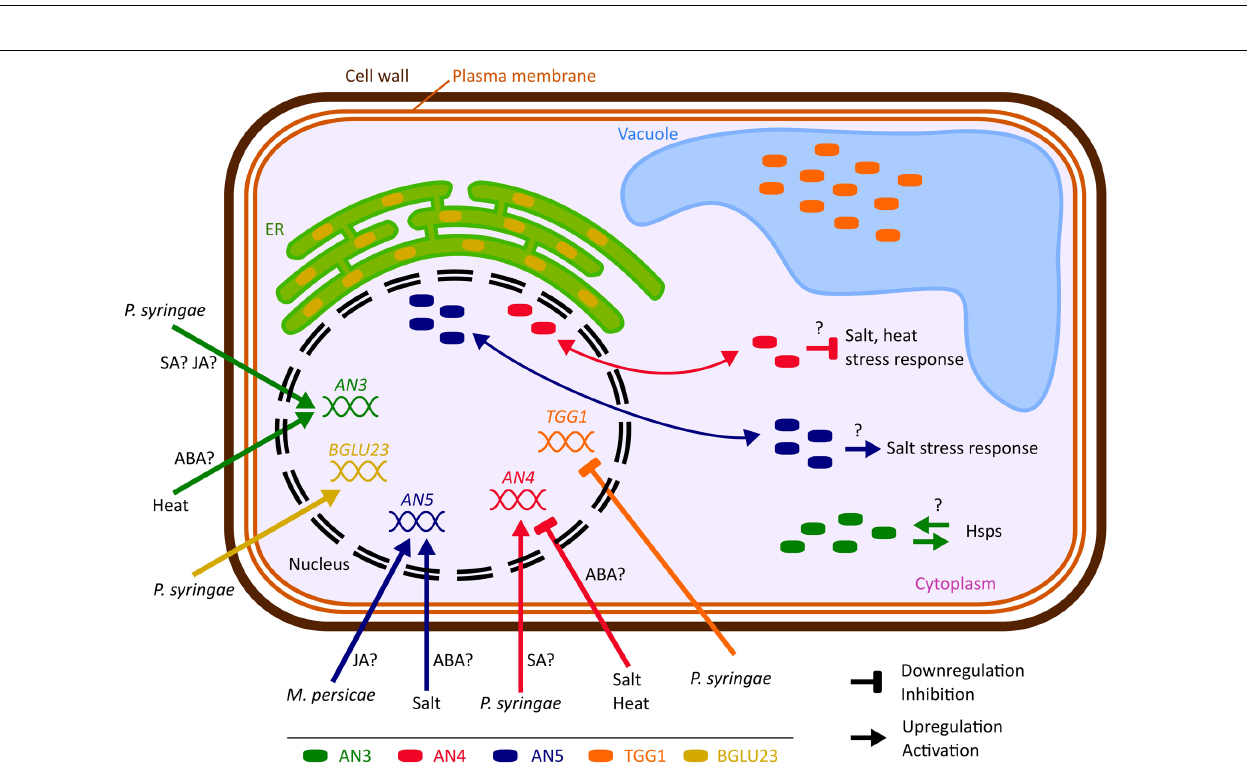
FIGURE 10 | Hypothetical model representing the biological importance of the ArathNictabas in A. thaliana cells. The cell and organelles are not drawn to scale. Data available from eFP browser suggest that BGLU23 is upregulated and TGG1 is downregulated after Pseudomonas infection.